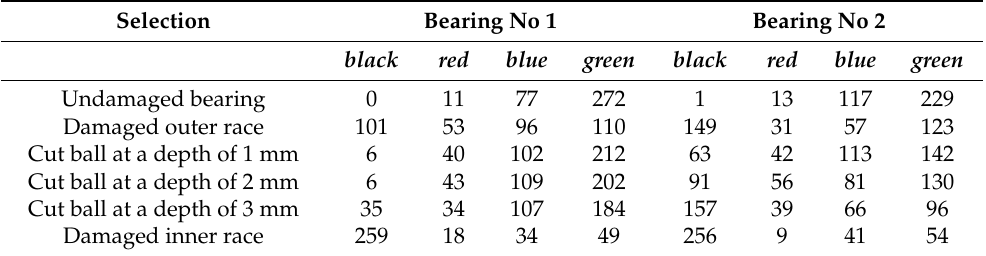
Table 5. Number of color fields in subsequent damage maps presented in Figures 8 and 9. Selection Bearing No 1 Bearing No 2 black red blue green